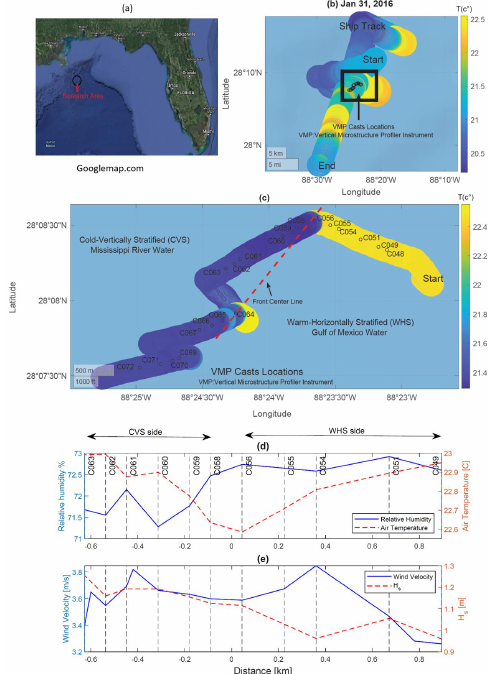
Figure 1. ( a ) The location of data collection in the northern part of the Gulf of Mexico (GOM). ( b ) The surface temperature colors the ship track. ( c ) The subdomain of the ship track where the VMP200 collected the vertical profiles of ocean properties is shown. The dashed red line shows the relative locations of the front center. ( d ) The relative humidity, ( d ) the air temperature, ( e ) the wind velocity, and ( e ) significant wave height, H s , are presented across the front. The vertical dashed-lines in graphs ( d , e ) give the horizontal distance of the VMP200 deployments for upcasts C049 to C063 from the front center shown by zero